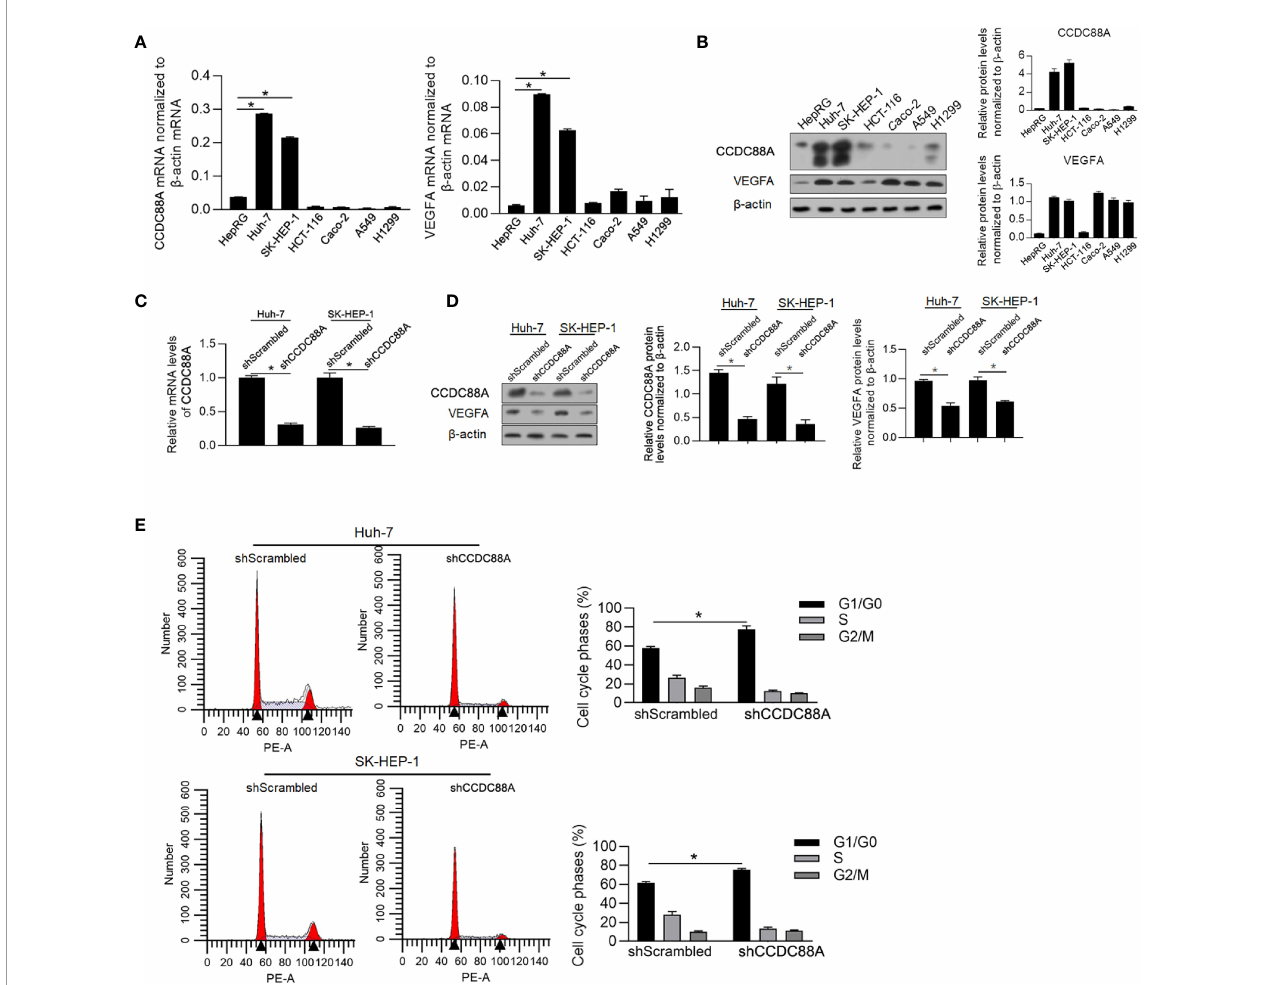
FIGURE 4 | CCDC88A is positively correlated with VEGFA and regulates cell proliferation. (A) RT-qPCR was performed to detect the mRNA level of CCDC88A in cancer cell lines, including Huh-7, SK-HEP-1, HCT-116, Caco-2, A549, and H1299, compared with HepRG. *P < 0.05, vs. HepRG group. (B) Western blot was performed to detect CCDC88A protein in all these cell lines. After transfecting shRNA target to CCDC88A mRNA (shCCDC88A), compared to scrambled shRNA (shScrambled), CCDC88A mRNA was detected in both Huh-7 and SK-HEP-1 cells (C) , and protein level was measured by performing western blot (D) *P < 0.05, vs. shScrambled group. (E) 48 h after shCCDC88A transfection, cell cycle phase distribution was measured by performing PI staining followed by fl ow cytometric analysis. *P < 0.05, vs. shScrambled